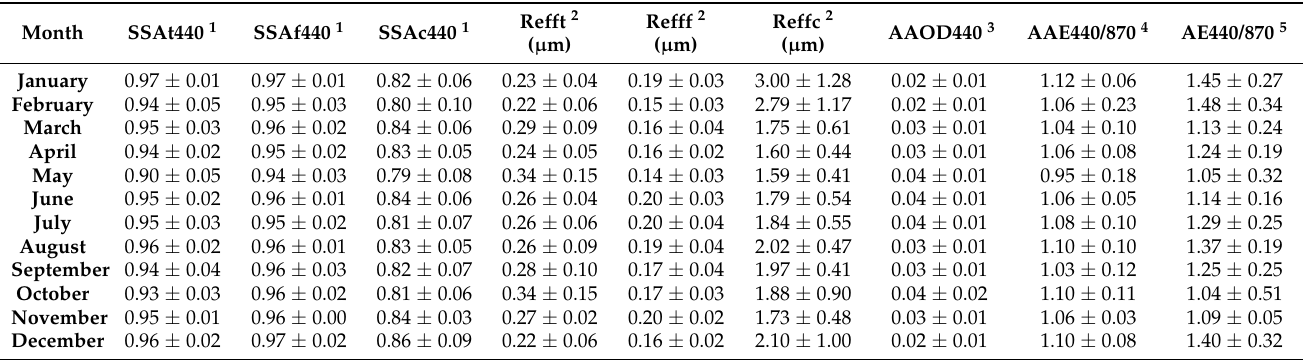
Table A1. Monthly and seasonal variations in size- and light-absorptivity-related AOPs. Both mean values and standard deviations are given.